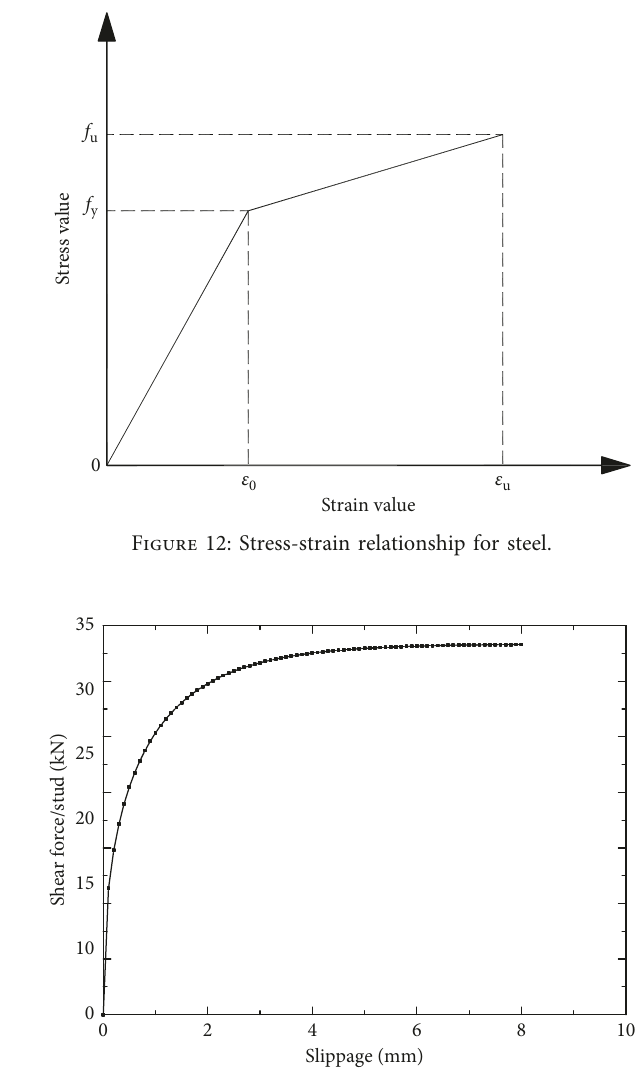
Figure 13: Shear force-slippage curve for the shear